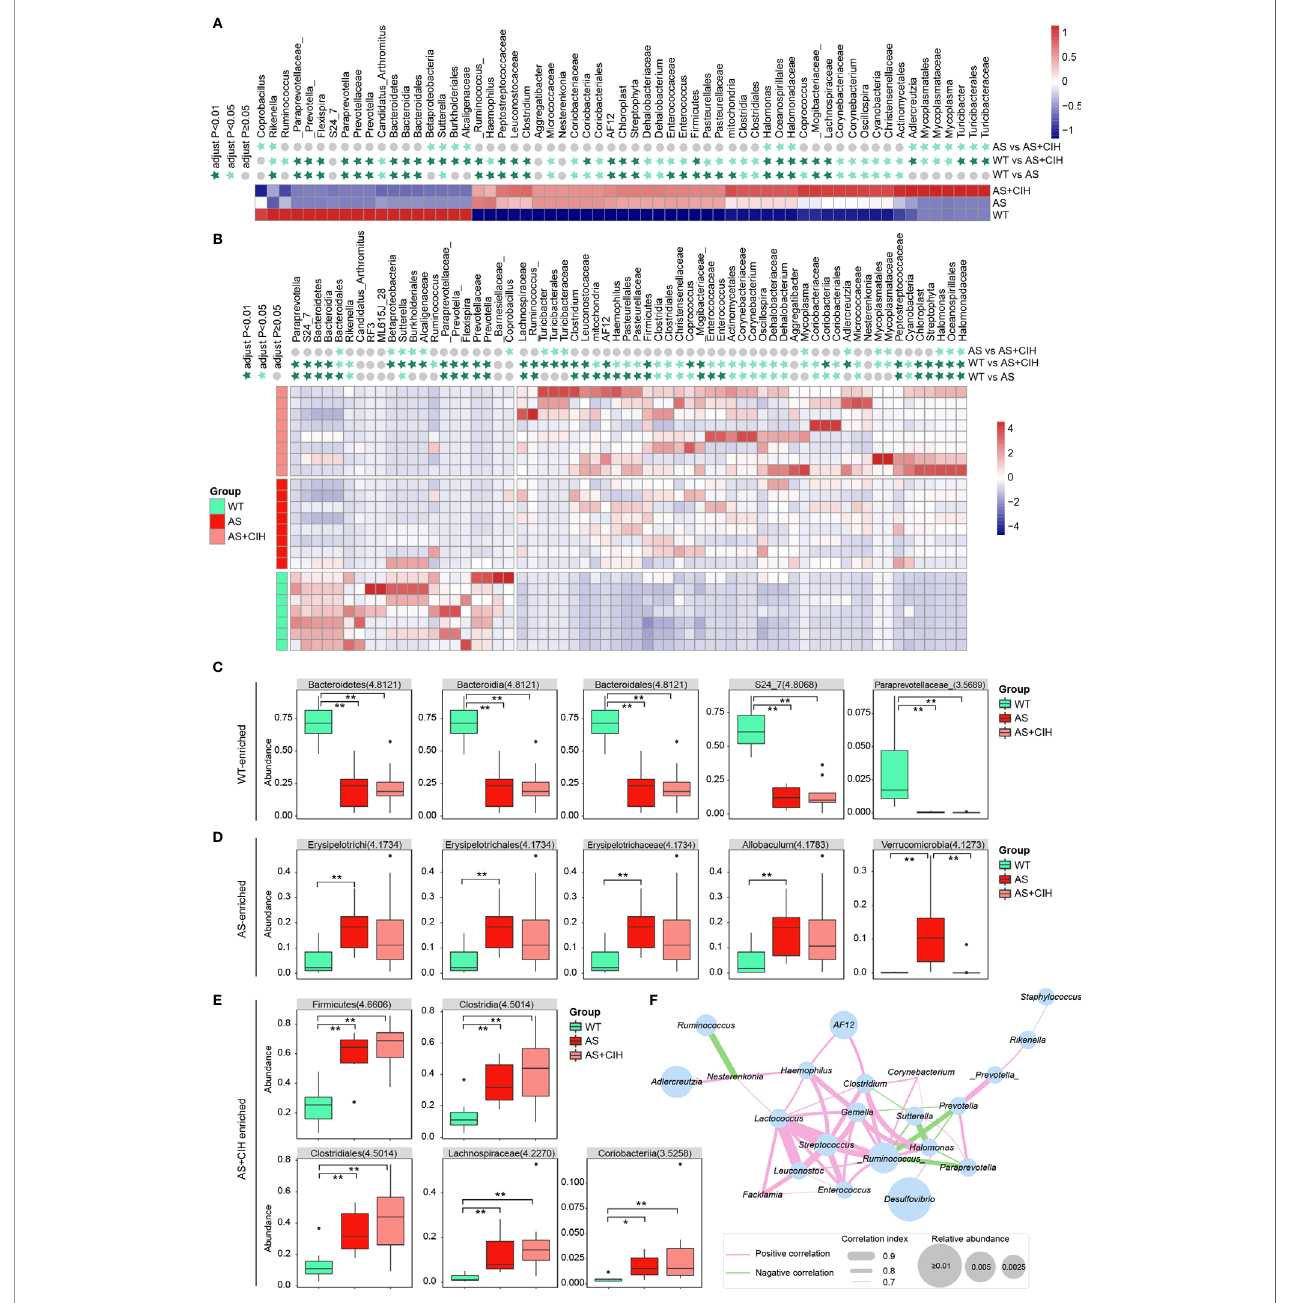
FIGURE 4 | Comparison of the bacteria potentially distinct among WT, AS and AS+CIH groups. (A, B) Relative abundances of the top 18 most signi fi cantly decreased bacteria and 43 most strikingly enriched taxon in AS+CIH. The taxa shown are statistically signi fi cant when all the three groups are included in the calculation. Panel a corresponds to the mean expression noted in the different groups and panel b is representative of the mean expression noted in the samples. The abundance pro fi les are transformed into the Z scores by subtracting the average abundance and dividing the standard deviation of all samples. The Z score is a negative blue indication when the row abundance is lower than the mean and a red indication when it is higher. The taxon at P value <0.01 is marked with dark green star, whereas when the P value <0.05 with light green star and when the P value ≥ 0.05 with gray circle. (C – E) Box plots showing relative abundance of the top 5 WT-enriched (C) , AS-enriched (D) and AS+CIH-enriched (E) bacteria, which varies signi fi cantly across the three groups. The boxes represent the inter quartile ranges, the lines inside the boxes denote medians and circles are outliers. The numbers in brackets indicate the LDA score in LEfSe analysis. * P value < 0.05, ** P value <0.01. (F) Co-occurrence network of the signi fi cantly different genera among groups. The thresholds derived from the Spearman ’ s correlation analyses are r ≥ 0.7 and P ≤ 0.05. The pink lines connecting two genera indicate positive correlation and the green lines represent negative correlation. The thickness of the line is proportional to the value of correlation and the size of the nodes is proportional to their relative abundance. n=7 for WT, and n=8 for AS and